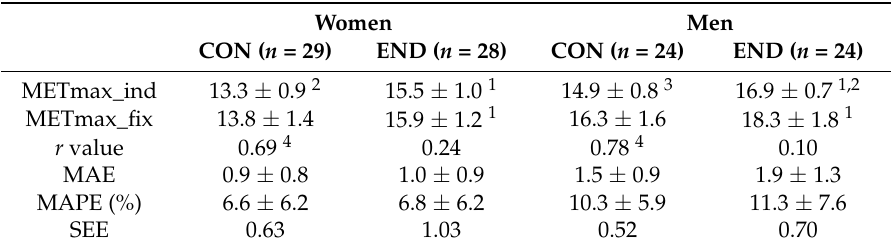
Table 2. Values and concurrent validity of the maximum metabolic equivalent of tasks (METmax) by use of the individual (METmax_ind) and conventional (METmax_fix, 3.5 mL∙kg −1 ∙min −1 ) 1-MET-value for calculating in endurance trained participants (END) and healthy controls (CON). Data are presented as Mean ± SD.